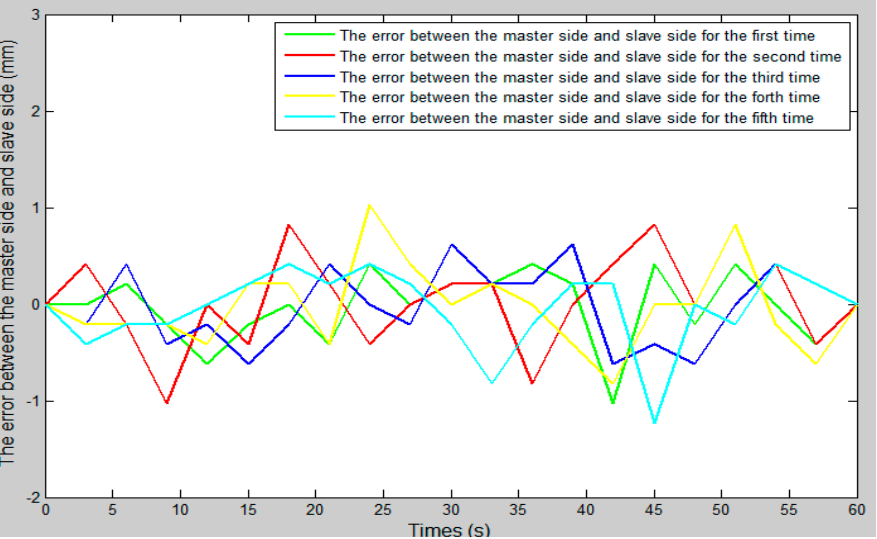
Figure 16. The error curve between the slave moving distance and the master moving distance.